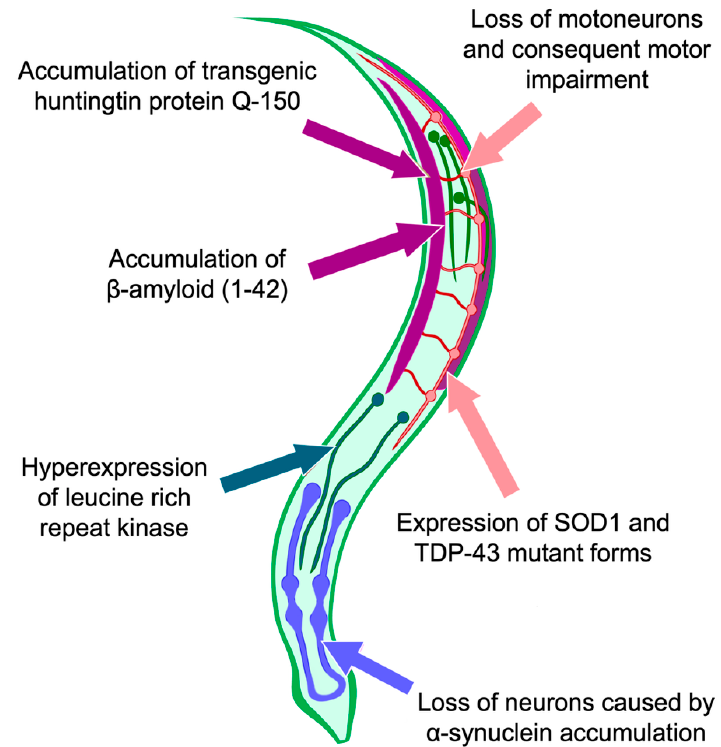
Figure 2. The study of complex action of factors leading to the loss of neurons and the connectome disruption integrity in the C. elegans body. The presence of neurons that differ in functions and types of neurotransmitters used, together with a strictly determined number of cells, make C. elegans an optimal object for connectome studies. Expression of mutant forms of superoxide dismutase and TAR DNA binding protein 43 results in motor neuron loss in C. elegans . This model serves to showcase the impact of processes, which are considered to be key mechanisms of amyotrophic lateral sclerosis development, Accumulation of huntingtin (number of CAG repeats 150) and amyloid β (the number of residues involved in the beta sheets formation is 42) demonstrates devastating consequences of Huntington’s disease and Alzheimer’s disease, respectively. Disrupted connectome in the case of Parkinson’s disease can be modeled through hyperexpression of leucine-rich repeat kinase. The advantage of using C. elegans as a connectome model lies not only in the small number of cells and its determinism but also in the permeability of the worm body to light, which makes it possible to conduct studies with fluorescent proteins included in